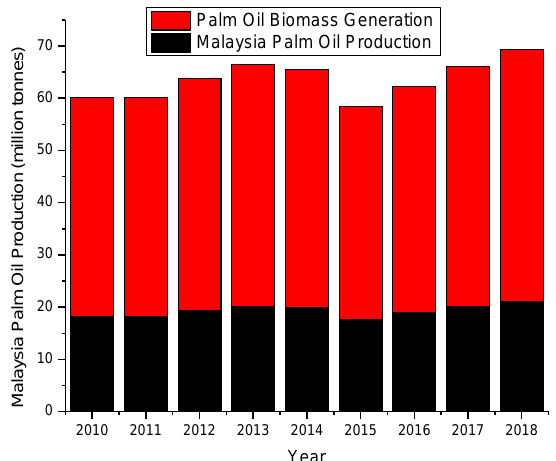
Figure 5. Annual Palm Oil Biomass Waste Generation in Malaysia, adapted from [33,35].